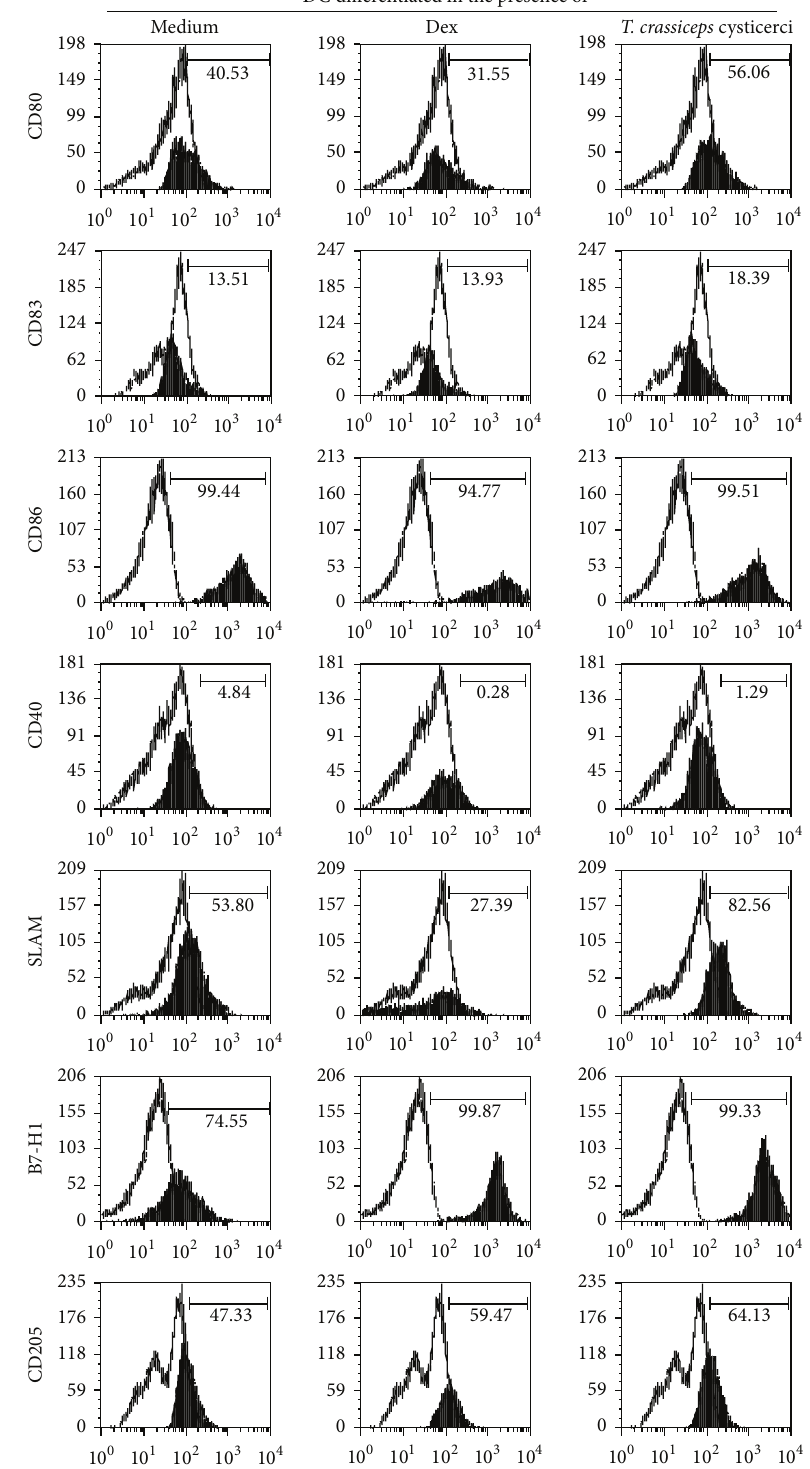
Figure 1: Parasite effect on DC differentiation and activation. Monocytes were differentiated to DC in presence of IL-4 and GM-CSF, plus medium or dexamethasone or Taenia crassiceps cysticerci. On day 8, the DC phenotype was studied. Representative data of three independent experiments are shown. Expression of CD80, CD83, CD86, CD40, SLAMF1, B7-H1, and CD205 gated on CD11c+ cells was analyzed by FACS. The isotype controls are shown in white